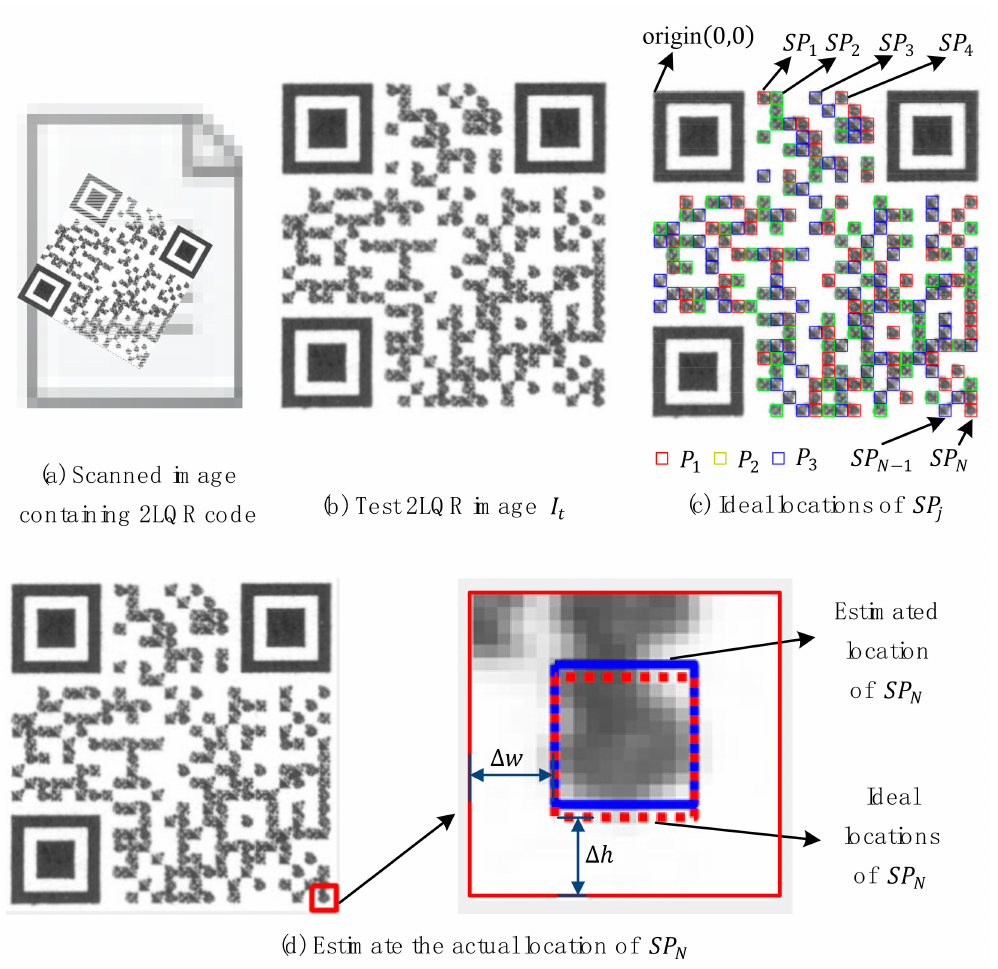
Figure 9. Key schematic of the process of estimating the actual locations of the